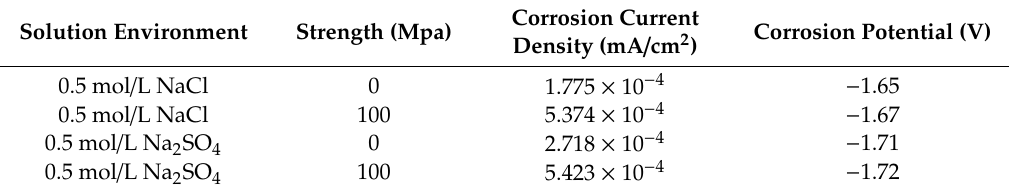
Figure 7. Tafel curves under 0 and 100 MPa in NaCl ( a ) and Na 2 SO 4 ( b ) aqueous solution. Table 3. The corrosion current density and corrosion potential of AM50Gd alloy tested under 0 and 100 Mpa in di ff erent solution